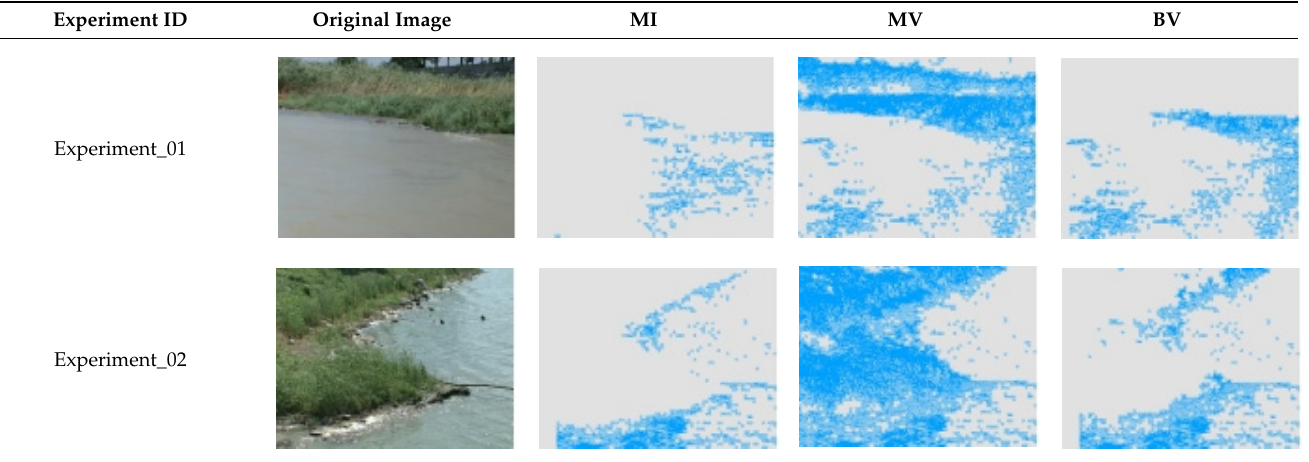
Table 2. Results of algal-bloom identification in algal areas. (Original image is the left video image; MI is the result of manual interpretation; MV is the recognition result using the method described in [31]; and BV is the recognition result using the proposed method).